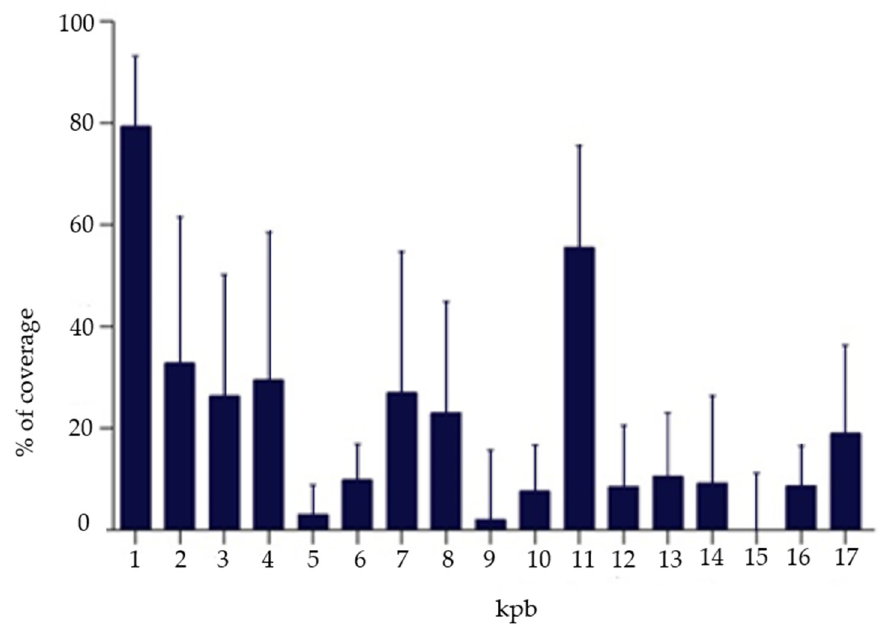
Figure 1. Percentage coverage for mitochondrial sequence after next generation sequencing per- formed on DNA from single cell after WGA.